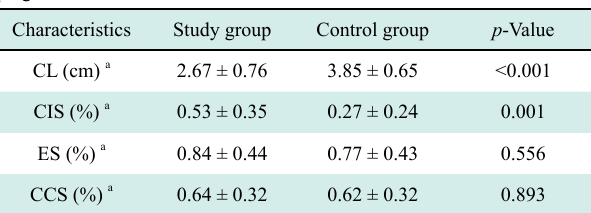
Table 2. Ultrasound and elastography characteristics of the cervix in